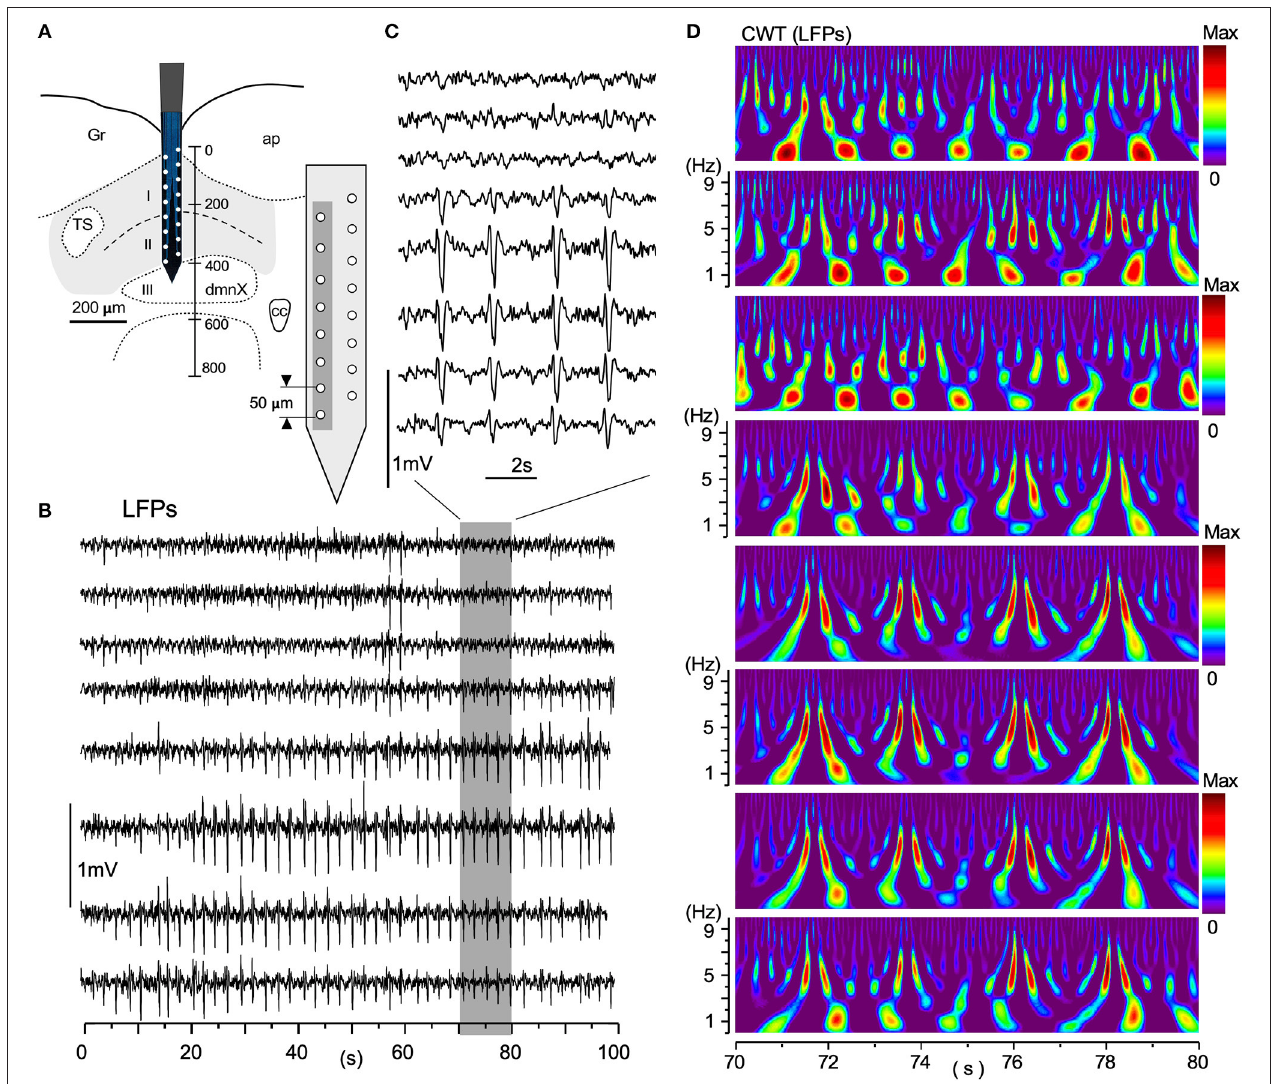
FIGURE 6 | A simultaneous multiple recording of local field potentials (LFPs). (A) A two-row silicon probe consisting of 16 electrodes each separated by 50 µ m in length and 400 µ m in depth, in the vagal complex (VC). (B) An example of LFPs of 100s duration from eight vertically arranged sites (gray in A ). (C) An expanded 10 s-duration-LFPs from a period of 70–80s in (B) (gray rectangle). (D) CWT time-resolved power spectrum results corresponding to this 10-s period of simultaneous recordings. Note that lower-amplitude LFPs in the dorsal VC have more intense signals of respiratory frequency range ( ventral cardiac range ( 5Hz). The spatial wave structure shaped by differential frequency ranges fluctuates temporally over 100s and higher-amplitude waves are ∼ noted in deeper layers (II and III) (B) . CWT, continuous wavelet